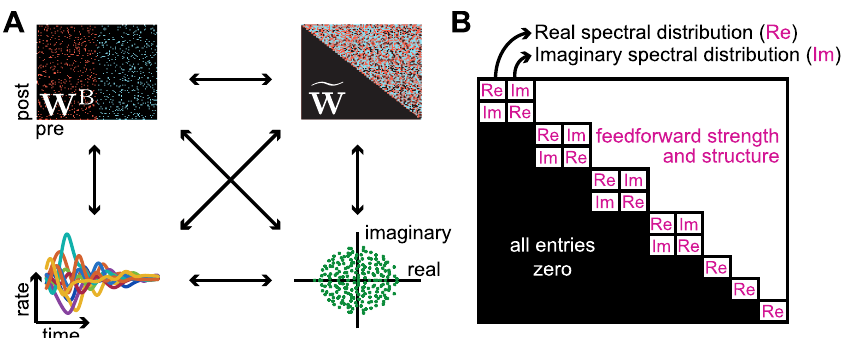
Fig 1. Elements explored in the manuscript. A , Schematic of the elements explored in this manuscript. Top left and clockwise: The connectivity matrix W B ; its corresponding Schur upper triangular decomposition f W ; the eigenspectrum; and the induced dynamics. In W B and f W , red dots indicate positive (excitatory) connections while blue dots indicate negative (inhibitory) connections. B , The upper triangular matrix f W with the quantities that we alter in this manuscript in pink.